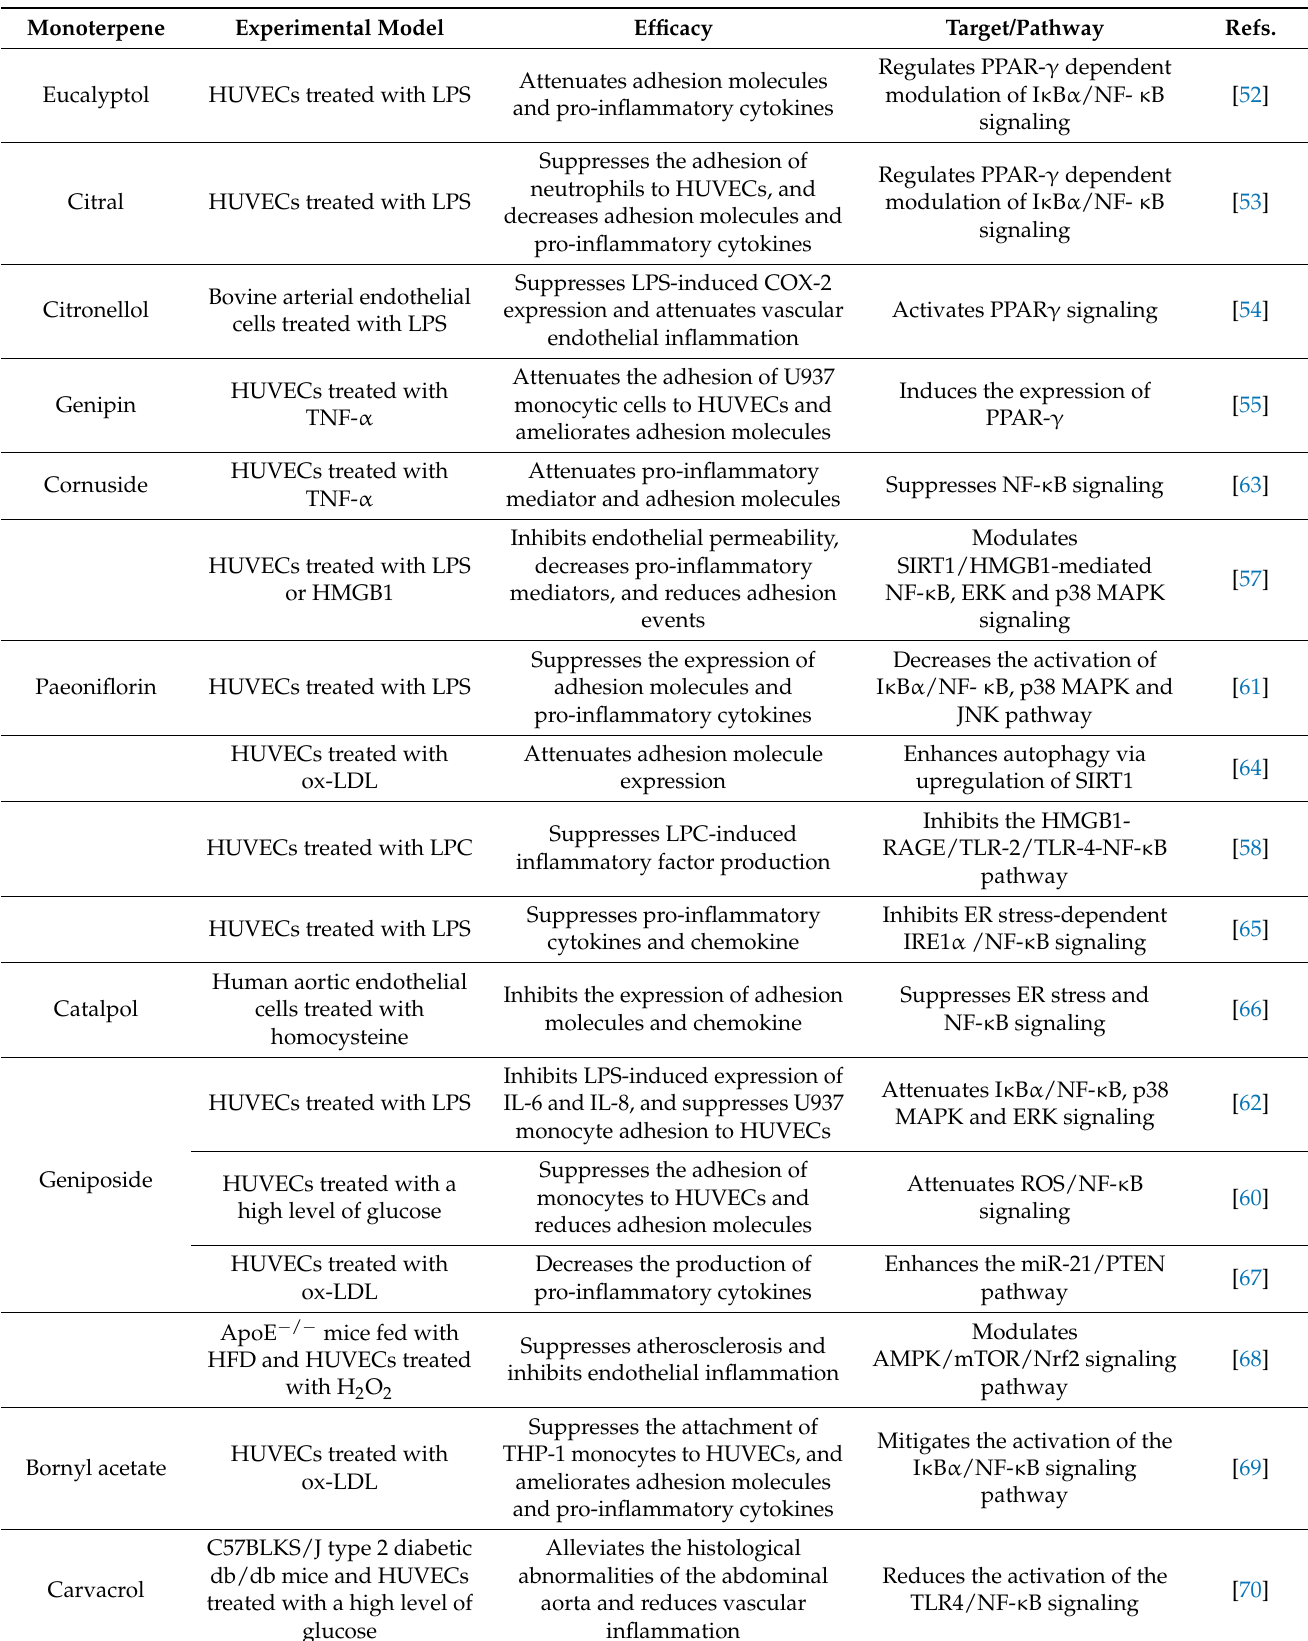
Table 2. Attenuation of endothelial pro-inflammatory